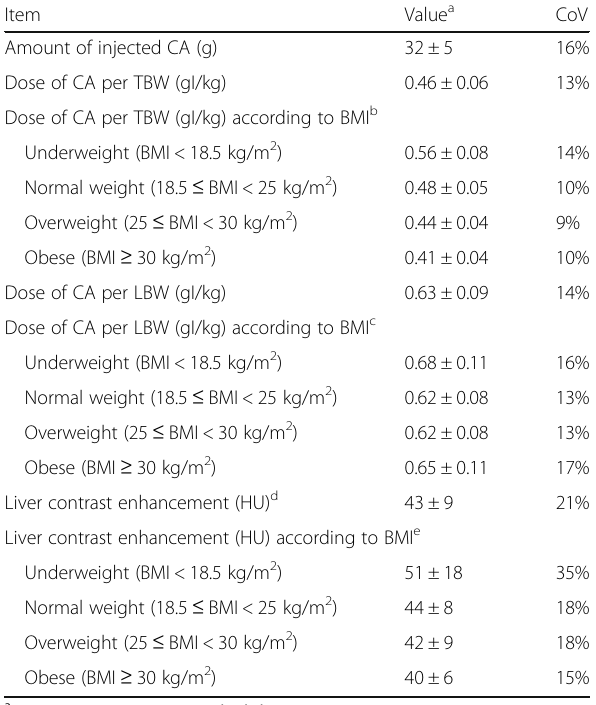
Table 2 Mean contrast agent dose administered in 201 patients of the study